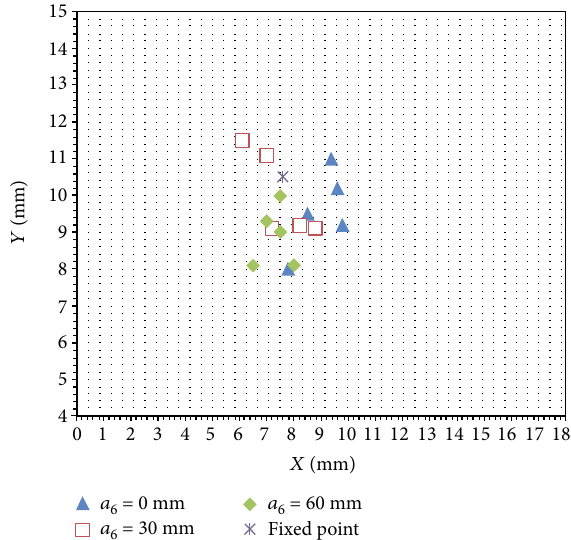
Figure 16: Remote center point error under the motion of pitching